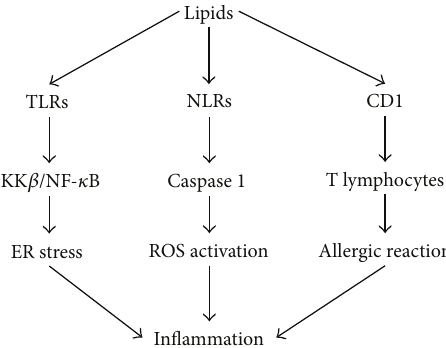
Figure 1: In fl ammation pathways induced by lipid. Lipid can be recognized by multiple molecules resident in cellular membrane, such as TLRs, NLRs, and CD1, to activate di ff erent signal pathways and ultimately induce in fl ammation. TLRs are responsible for IKK β /NF- κ B and ER stress augment, while NLRs activate Caspase1 expression and induce ROS production. Besides, lipid captured by CD1 can be presented to T lymphocytes directly. All these signals participate in translating lipids to in fl ammatory